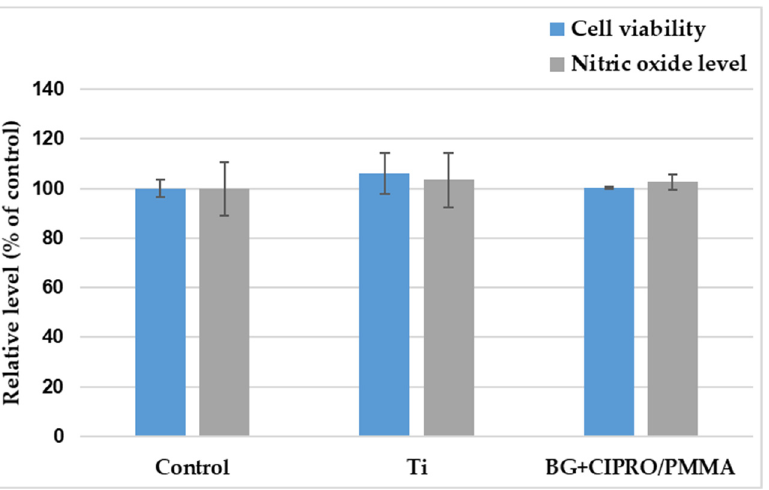
Figure 12. MTT (cell viability) and Griess (NO level). Results are presented as mean ± standard deviation of three independent experiments and represented as percentages of control.